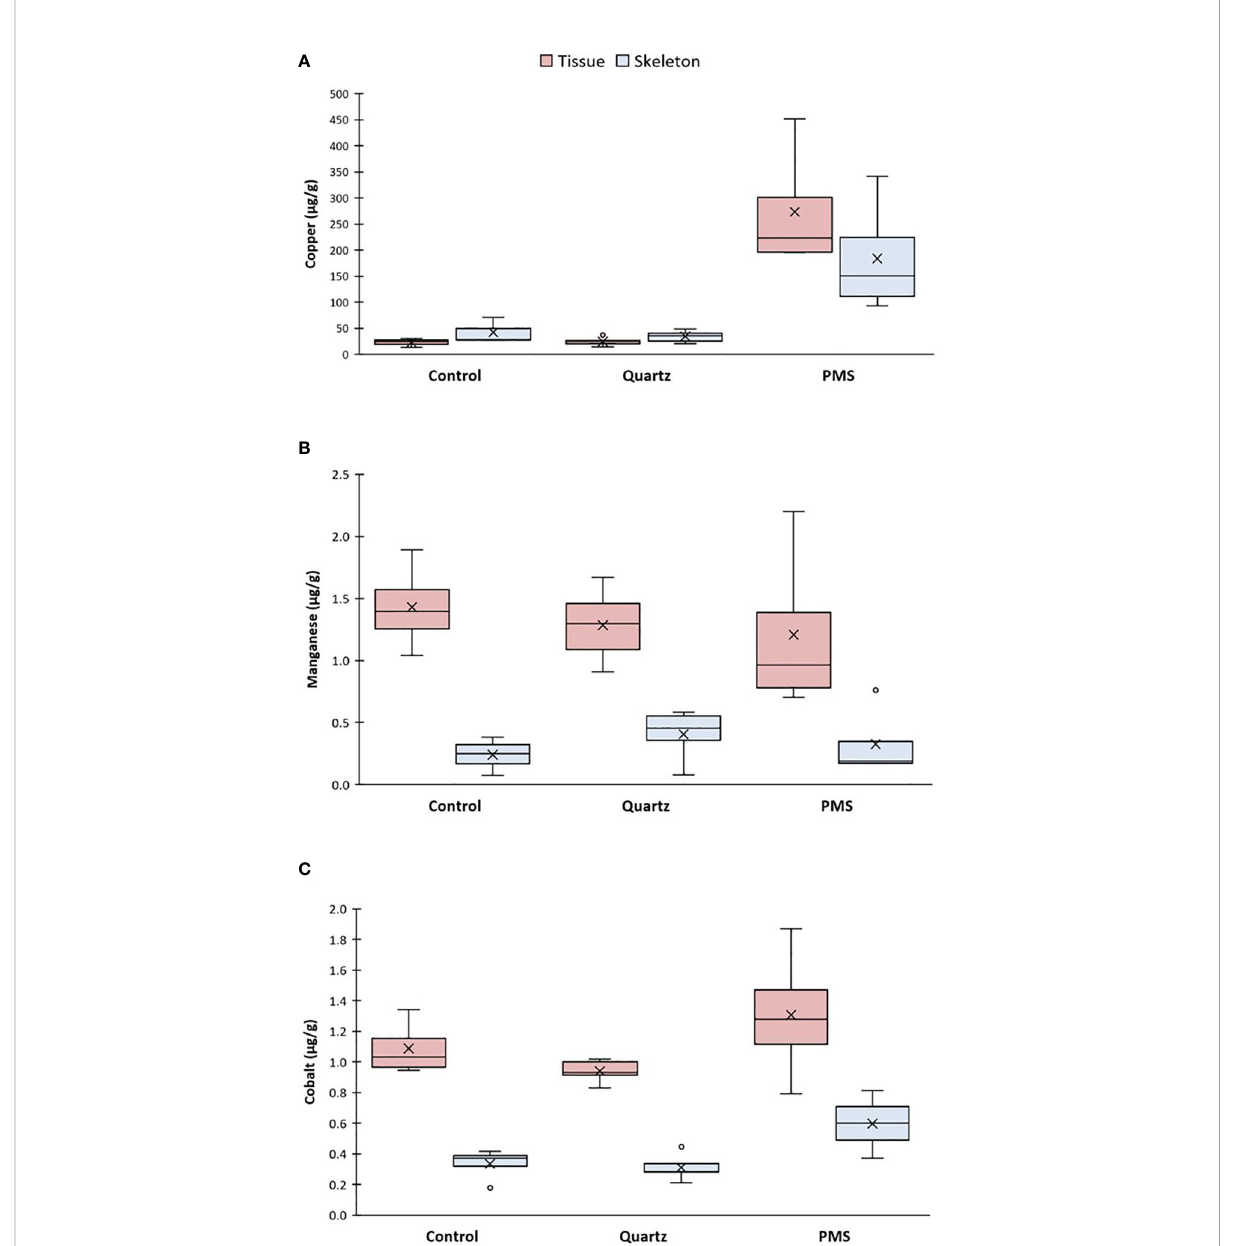
FIGURE 5 (A-C) Metal accumulation in tissue and skeleton fractions of Dentomuricea aff. meteor exposed to the treatments with polymetallic sulphide particles (PMS), with quartz particles (Quartz), and a control treatment with no sediment addition, at times 25-27 days for PMS and 27 days for control and quartz. N=4-5, data presented as µg − 1 dry weight tissue or skeleton. The line in the box is the median, and the X is the mean. Whiskers represent the highest and lowest values and outliers are identi fi ed by a circle ( ○